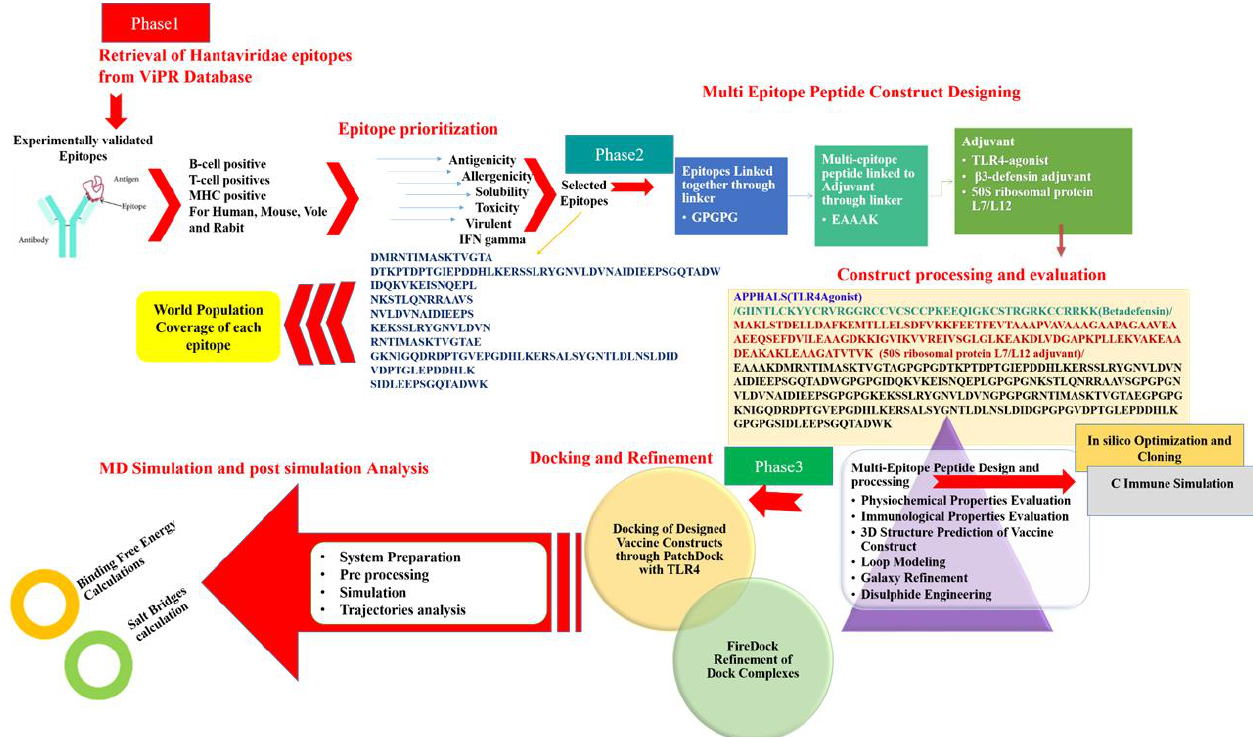
Figure 1. The schematic representation of steps followed throughout the